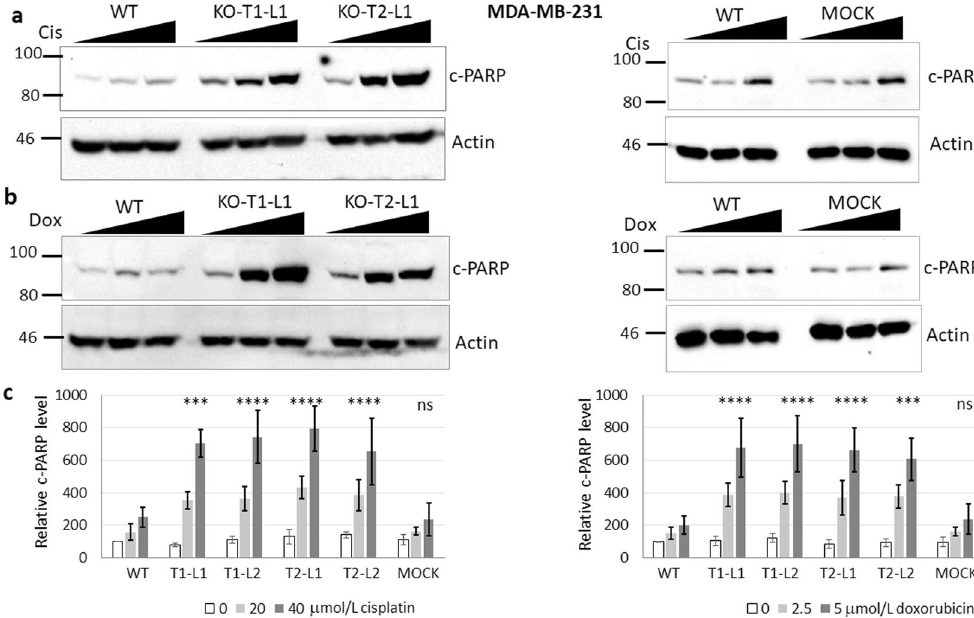
Figure 3. Effect of BMAL1 mutations on apoptosis induced by cisplatin and doxorubicin agents in p53 mutant cell line MDA-MB-231. ( a , b ) Cells were treated with 0, 20, and 40 μ mol/L cisplatin or 0, 2.5, and 5 μ mol/L doxorubicin for 16 h. Cell lysates were probed for cleaved PARP (c-PARP) by immunoblotting. Actin served as a loading control. ( c ) Quantifications of the c-PARP levels normalized to actin are plotted and show that BMAL1 mutations sensitized these cells to cisplatin or doxorubicin-induced apoptosis. The data are the mean of three independent experiments ± SD. P-values are given for the apoptosis induced by 40 μ mol/L cisplatin or 5 μ mol/L doxorubicin in BMAL1 knockouts relative to the parental cells. Numbers and marks on the left of each figure indicate the positions of the corresponding molecular size markers in kDa. KO indicates BMAL1 knockouts generated by T1 or T2 sgRNA targeting, L indicates subclone for each sgRNA targeting. Relative c-PARP was analysed by two-way ANOVA followed by Tukey’s post hoc tests for pairwise comparisons. *** P < 0.001, **** p < 0.0001, ns; not significant (the details are available in Supplementary Table 1). Full-length blots are presented in Supplementary Fig.